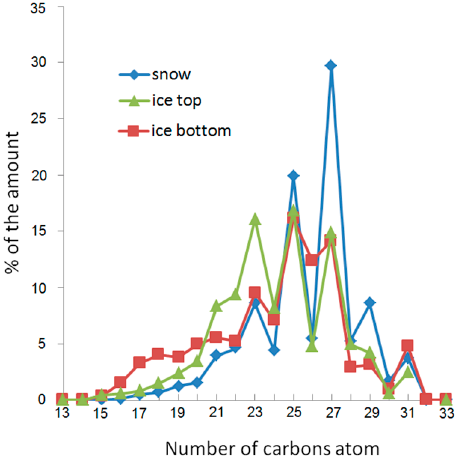
Figure 9. Composition of alkanes in the snow-ice cover of the Onega River mouth in low tide in February 2017.